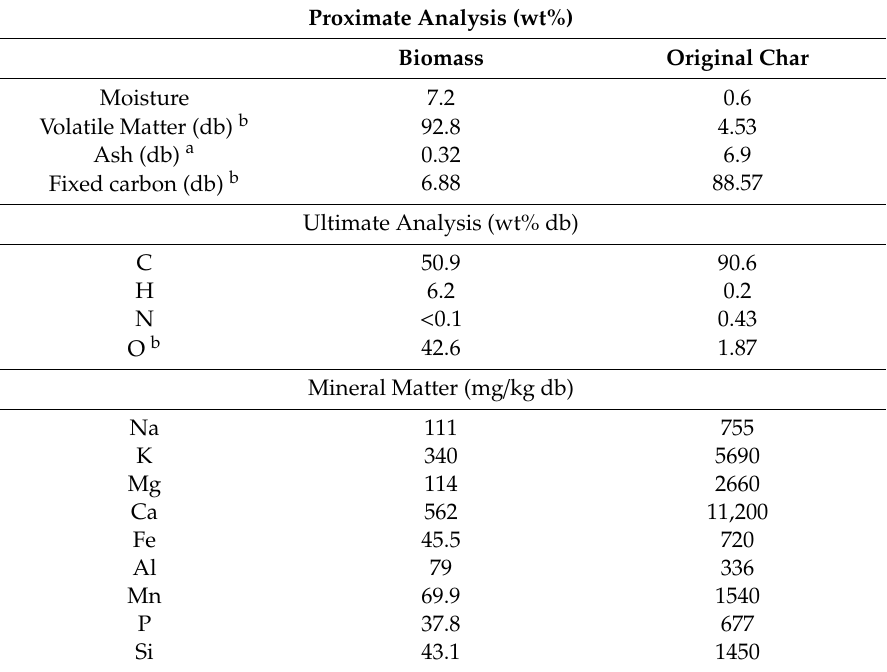
Table 1. Ultimate and proximate analyses of biomass and original